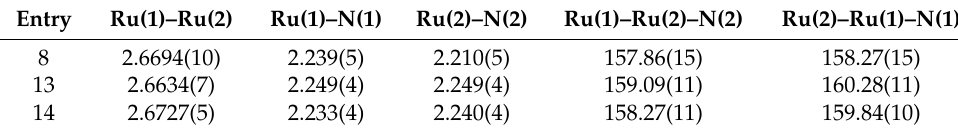
Figure 1. Molecular structures of 8 (H atoms are omitted for clarity). Table 1. Selected Bond Distances (Å) and Angles (deg) for 8 , 13 and 14.